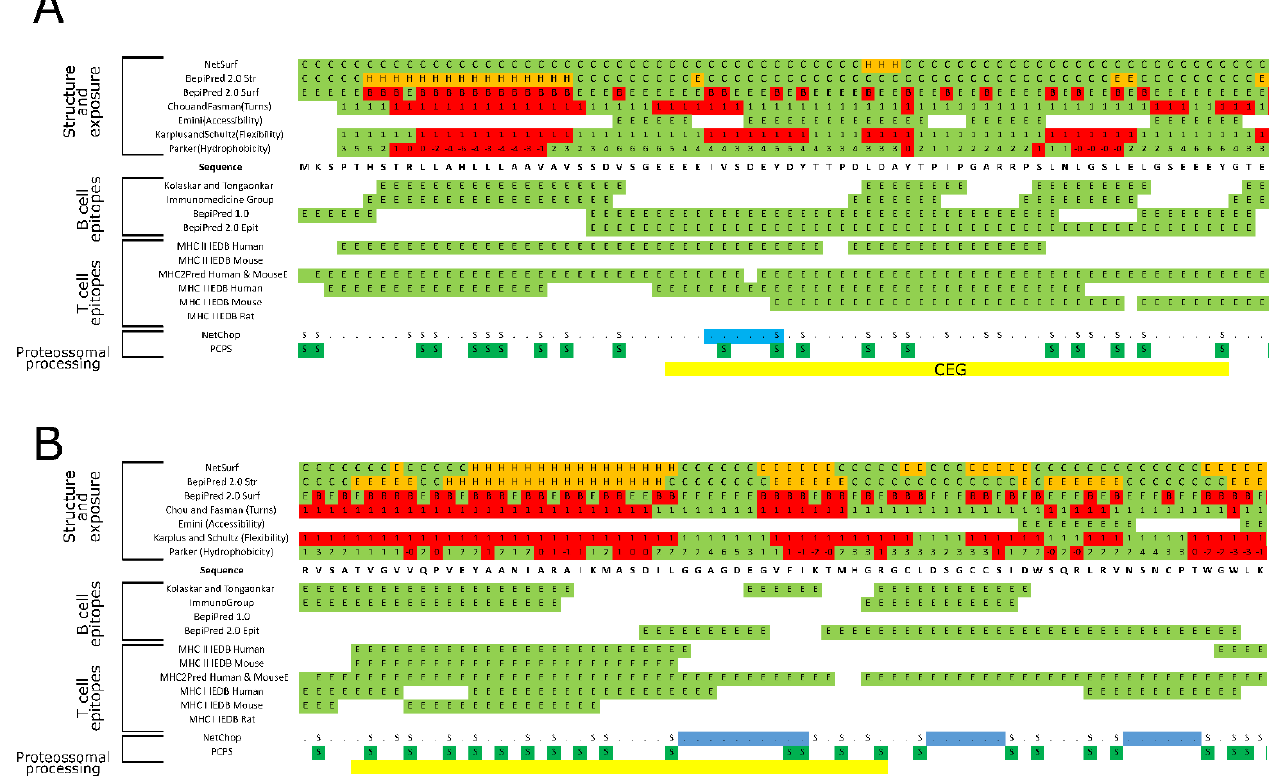
Figure 3. In silico analysis of the two putative signal proteins: EVASIN and RICIN. Identification of overlapping coincident epitopes groups (CEGs) within ( A ) EVASIN and ( B ) RICIN amino acids sequences. For detailed information see Supplementary material—Spreadsheet S4 and S5.